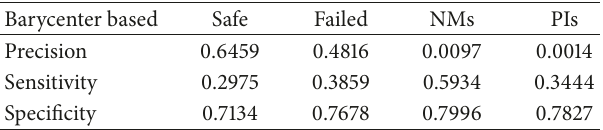
Table 5: Stand-alone SSSOM performances: precision, sensitivity, and specificity for each